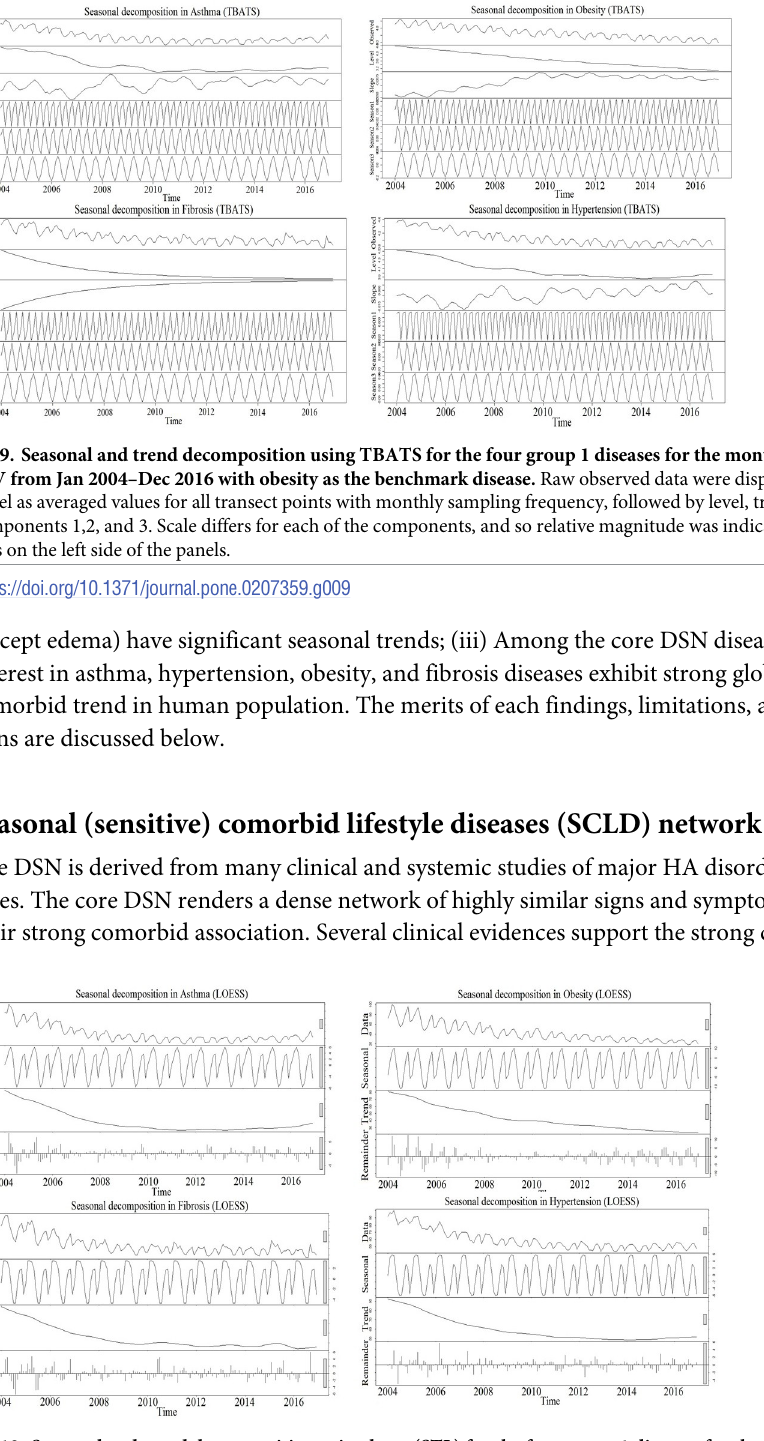
Fig 10. Seasonal and trend decomposition using loess (STL) for the four group 1 diseases for the monthly collected RSV from Jan 2004 –Dec 2016 with obesity as the benchmark disease. Raw data are displayed in the top panel as averaged values for all transect points with monthly sampling frequency, followed by seasonal, trend, and residual components. Scale differs for each of the components, and so relative magnitude was indicated by the gray bars on the right side of the